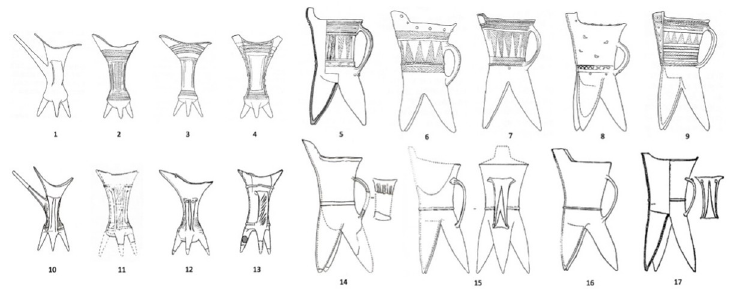
Fig 5. Comparison of pottery tripod vessels from Dadianzi (1–9) and Erlitou (10–17).